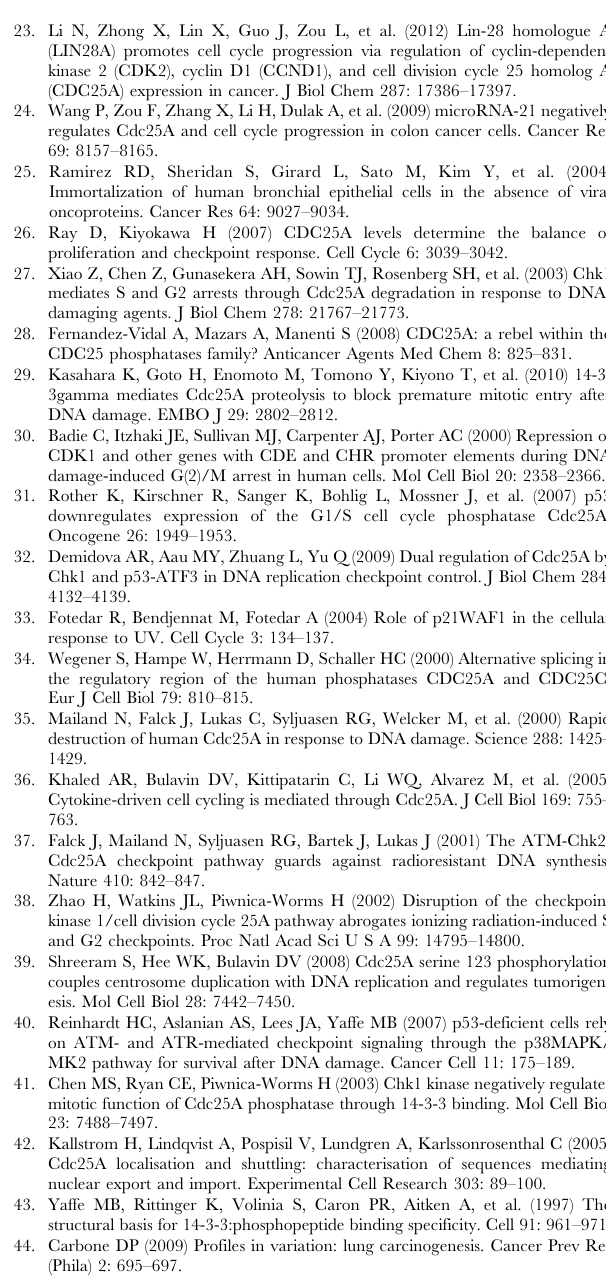
Table S4 CDC25A wt in NSCLC tumor versus normal tissue pair in correlation to overall patient survival. (DOCX) Table S5 CDC25A wt in NSCLC tumor versus normal tissue pair and demographic